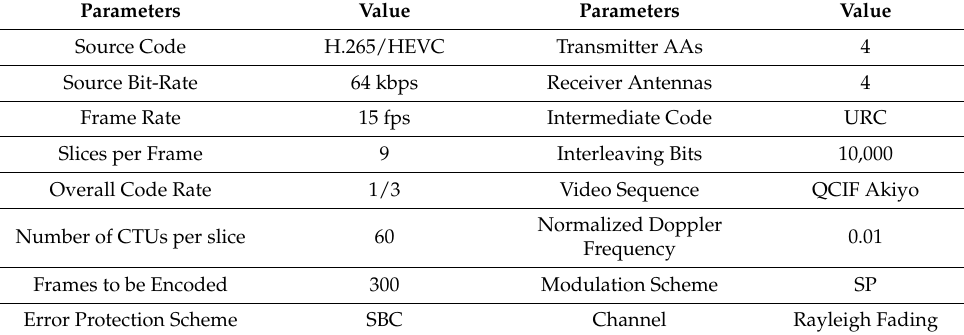
Table 3. Proposed system